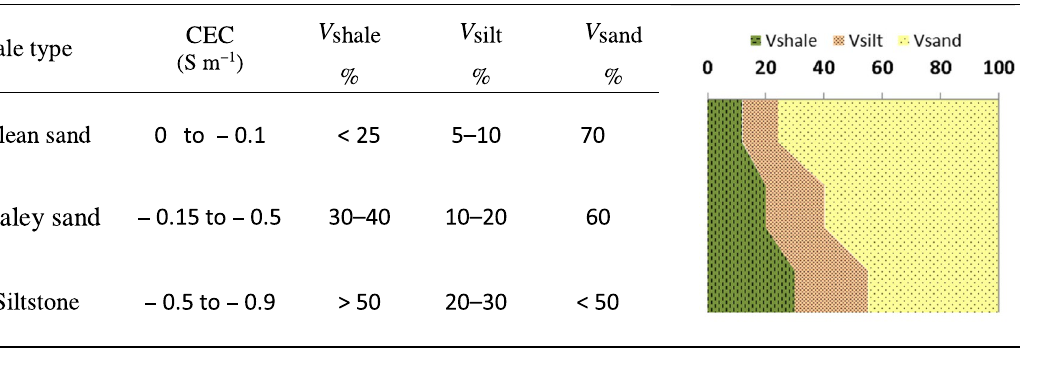
Table 7 Integrated water saturation results of core and log interpretation on same plugs